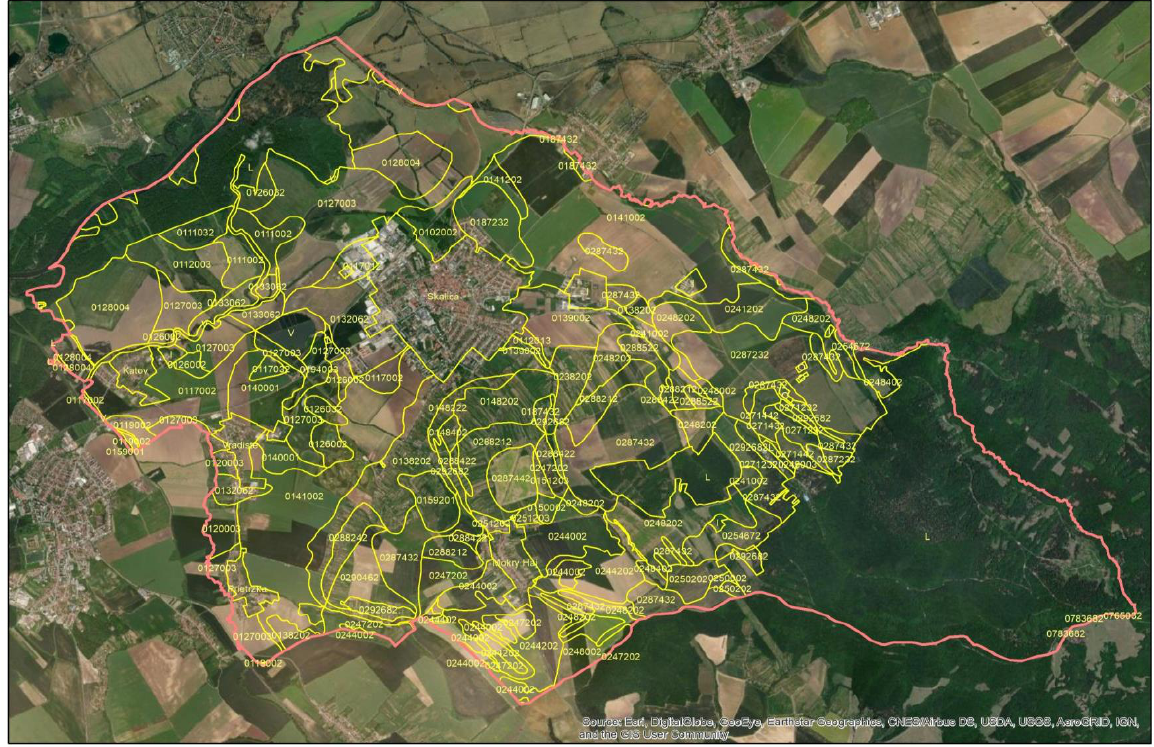
Figure 2. Map representation of value soil ecological units of the model area.